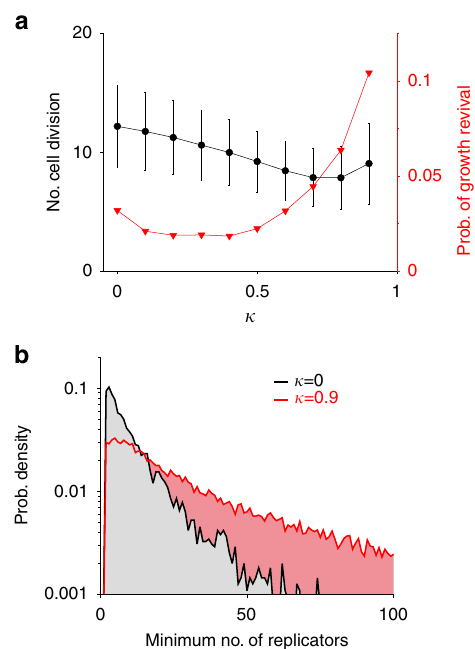
Fig. 6 The bene fi t of kinetic symmetry breaking. a . The probability of bottleneck-induced growth restoration ( triangle , right coordinate), and the average number of cell divisions a protocell undergoes along a single line of descent ( circles , left coordinate; error bars, s.d.), as a function of the degree of kinetic asymmetry ( κ ). See Methods section for the details of measurements (under ‘ The measurement of the probability of growth restoration ’ ). b . The empirical probability density of the minimum number of replicators in a protocell that successfully restored its